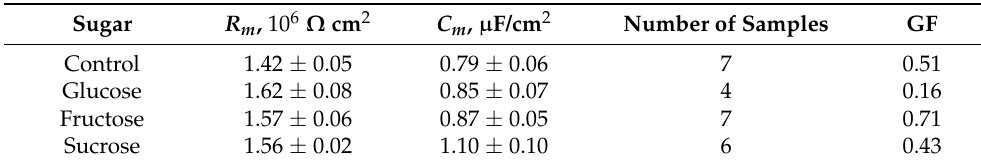
Figure 3. Impedance spectra plots in the complex plane (Nyquist diagrams) measured for POPC BLMs in 1 mmol/L NaCl (solid circles) and 200 mmol/L of sucrose (hollow circles). Lines represent equivalent model circuit fits. Table 2. Specific capacitance and resistance of POPC membranes in aqueous solutions containing 1 mmol/L NaCl and 200 mmol/L glucose, fructose or sucrose; data obtained from FFT-EIS of BLMs by equivalent model circuit fits; control samples contain only 1 mmol/L